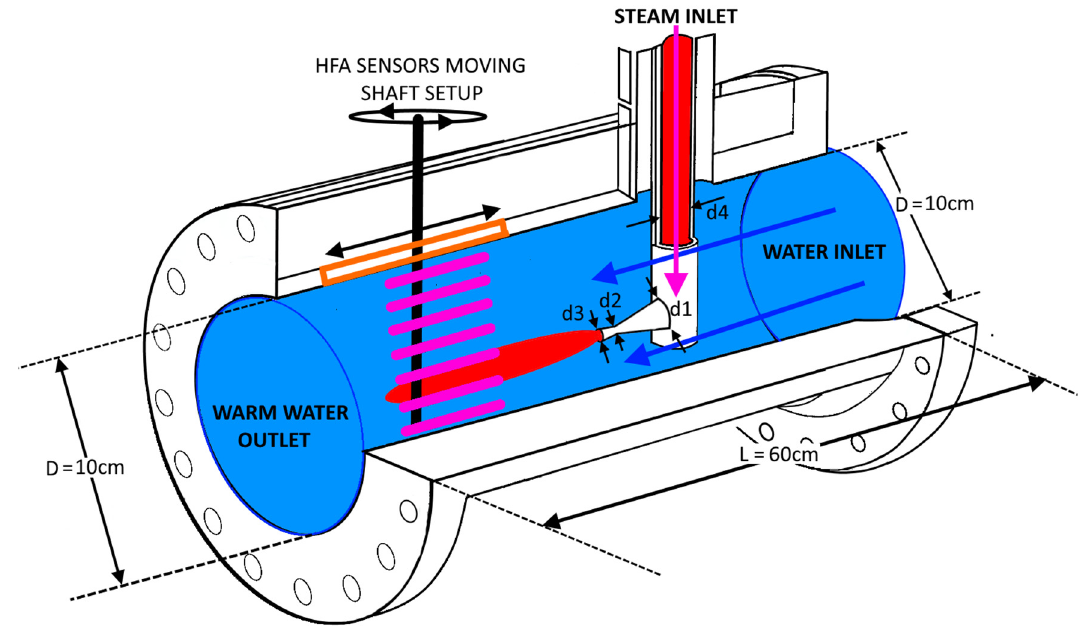
Figure 1. An experimental setup of the desuperheating vessel.